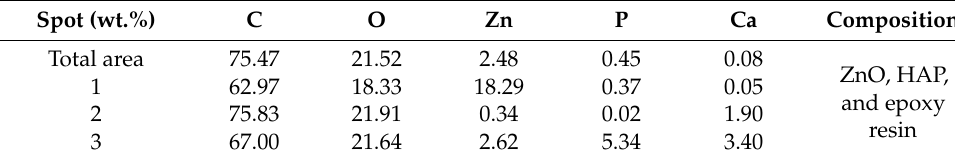
Table 3. Grades of GB/T9286-1998 color paint and paint film grid test.